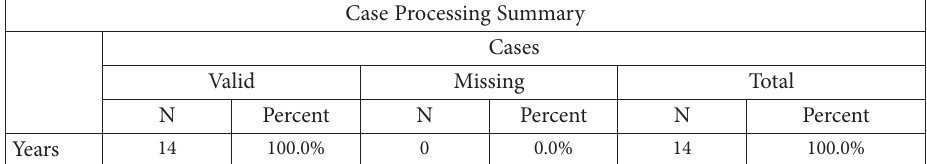
Table 1. Case processing